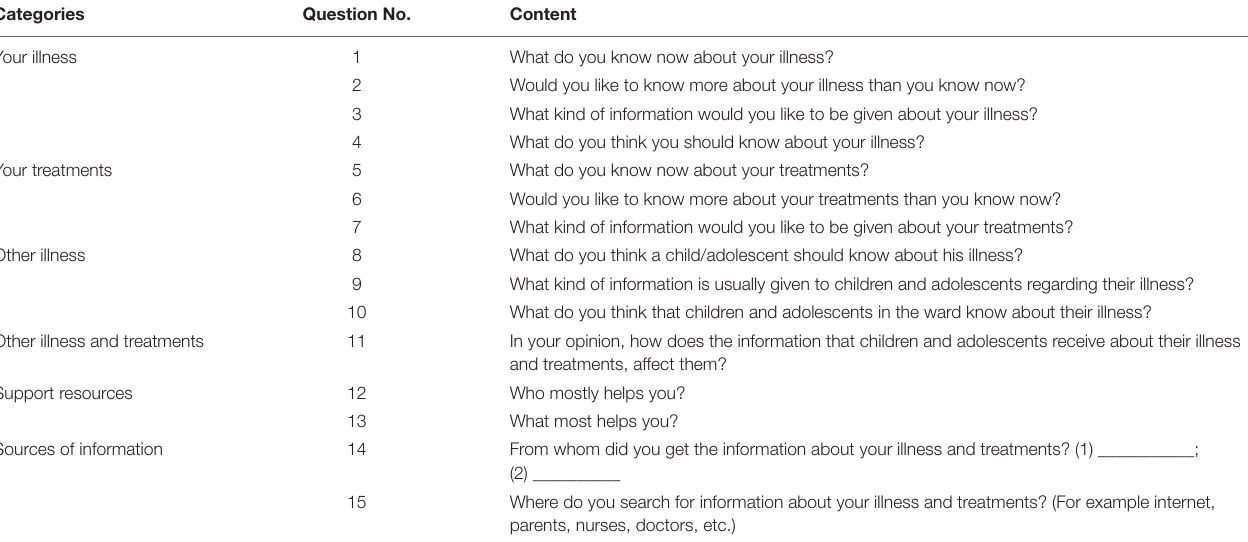
TABLE 2 | Fifteen questions that guided the study. Categories Question